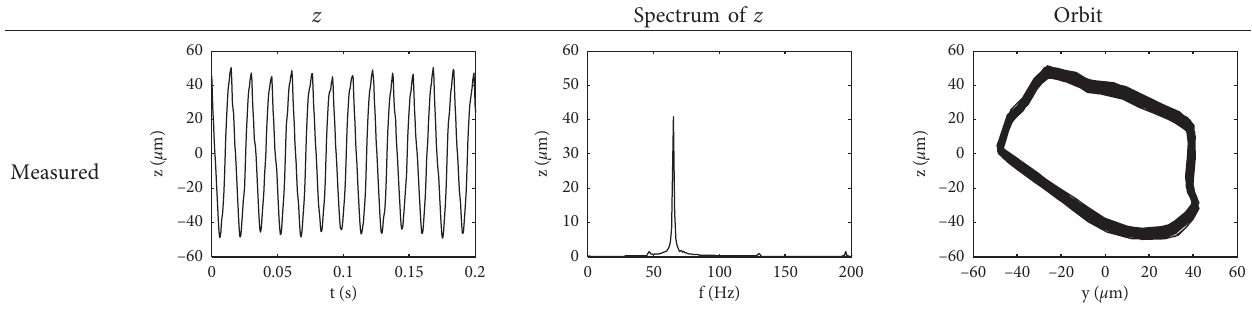
Table 5: Comparison of the vibration responses under normal condition ( h �